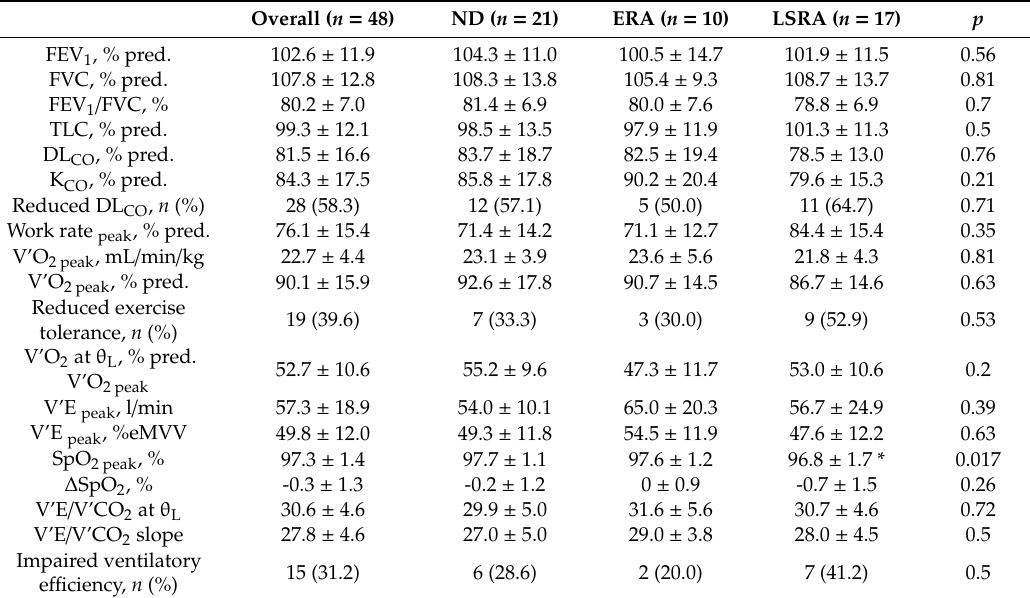
Table 2. Selected pulmonary functional responses measured at rest and during exercise testing. ND ( n = 21) ERA ( n = 10) LSRA ( n =